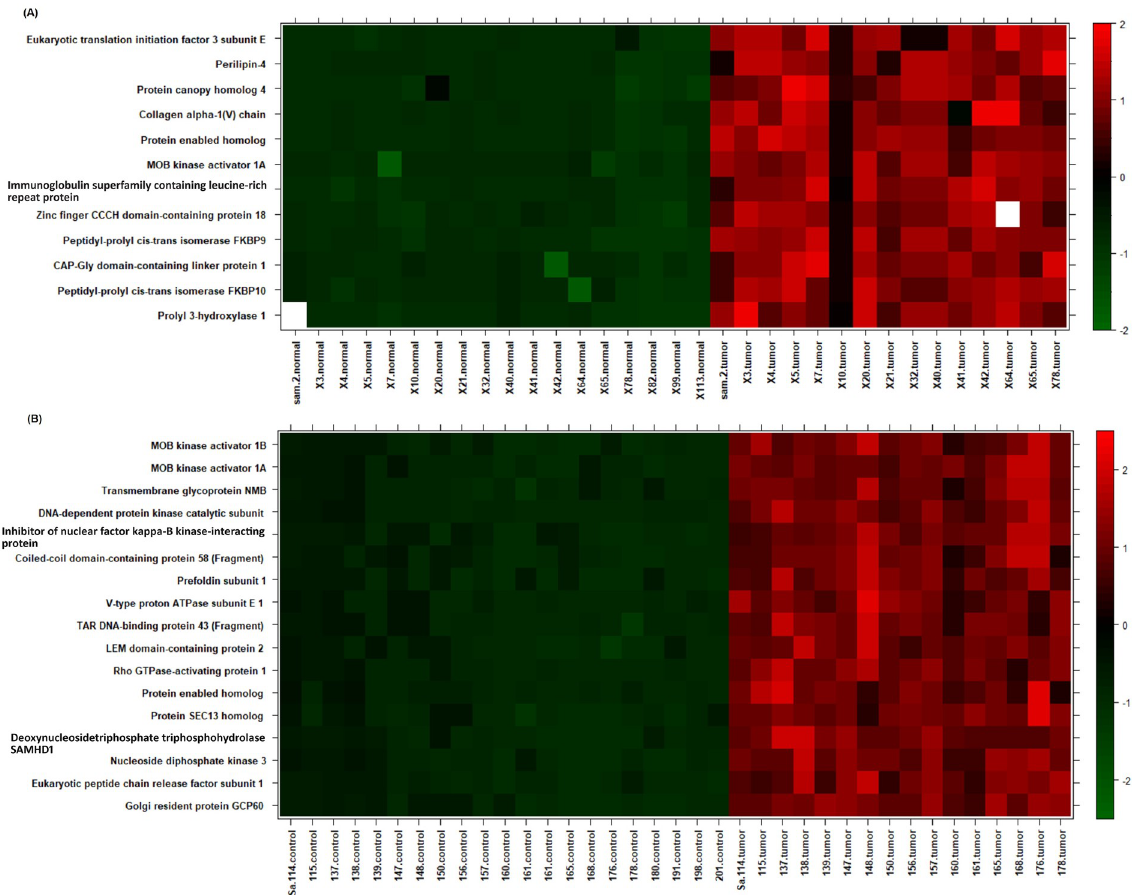
Fig 3. Heat map analysis of the detected proteins in stage 2 and 3 of the tumor and normal breast tissues. Heatmap of significantly different proteins between tumor and normal breast tissues. Samples on x-axis were ordered by tumor or normal group. The color code denotes z-scaled values of proteins signal